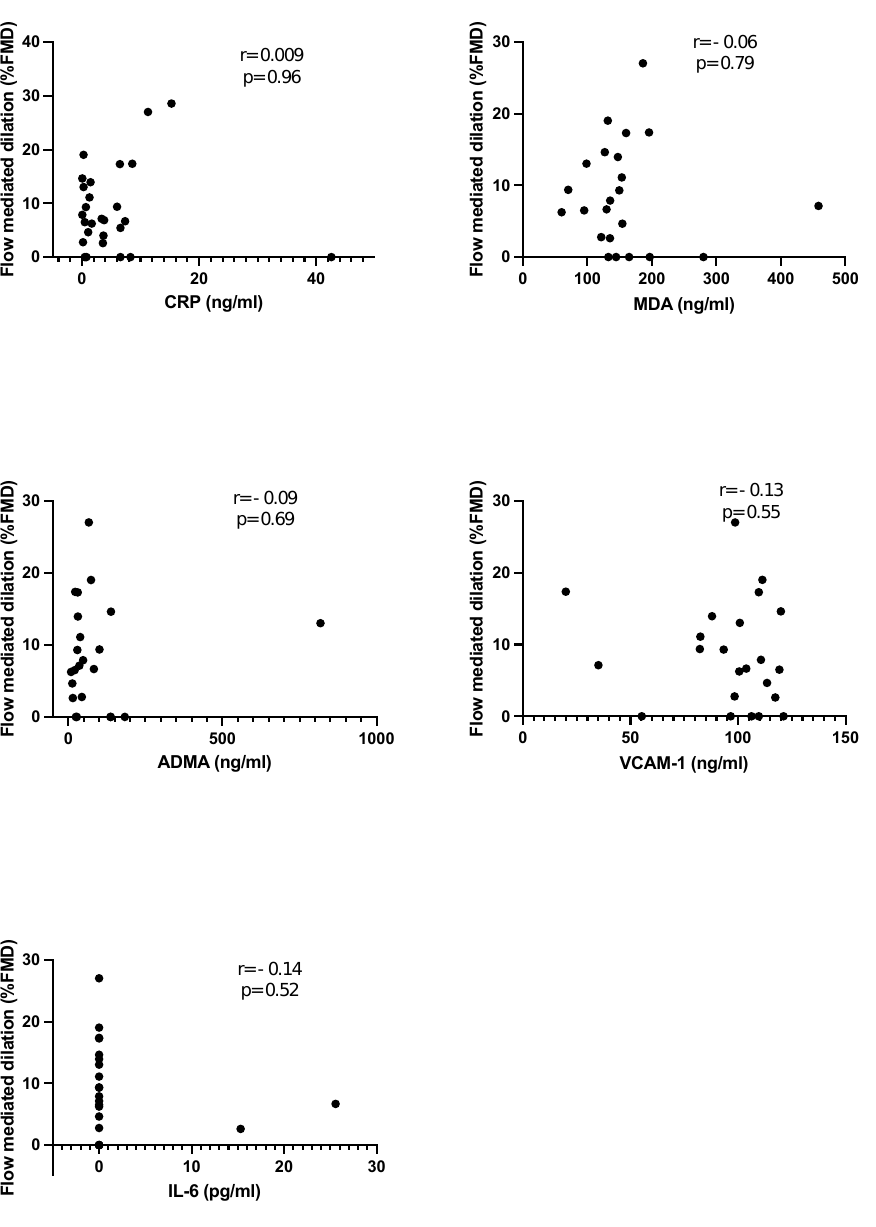
Figure 2. Group of study (lithiasic patients). Linear correlation between serum markers and DMF%.